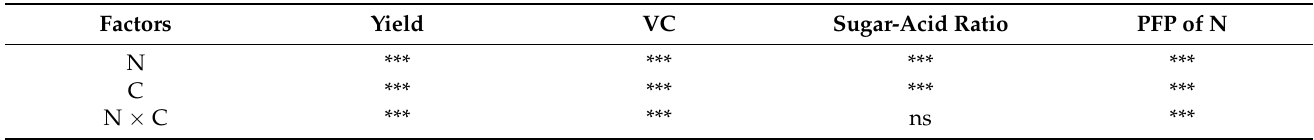
Table 5. Output of two-way ANOVA of tomato yield, sugar-acid ratio, VC, and PFP of N as affected by N (N1, N2, N3, N4) and biochar (C0, C30, C50, C70). Factors Yield VC Sugar-Acid Ratio PFP of